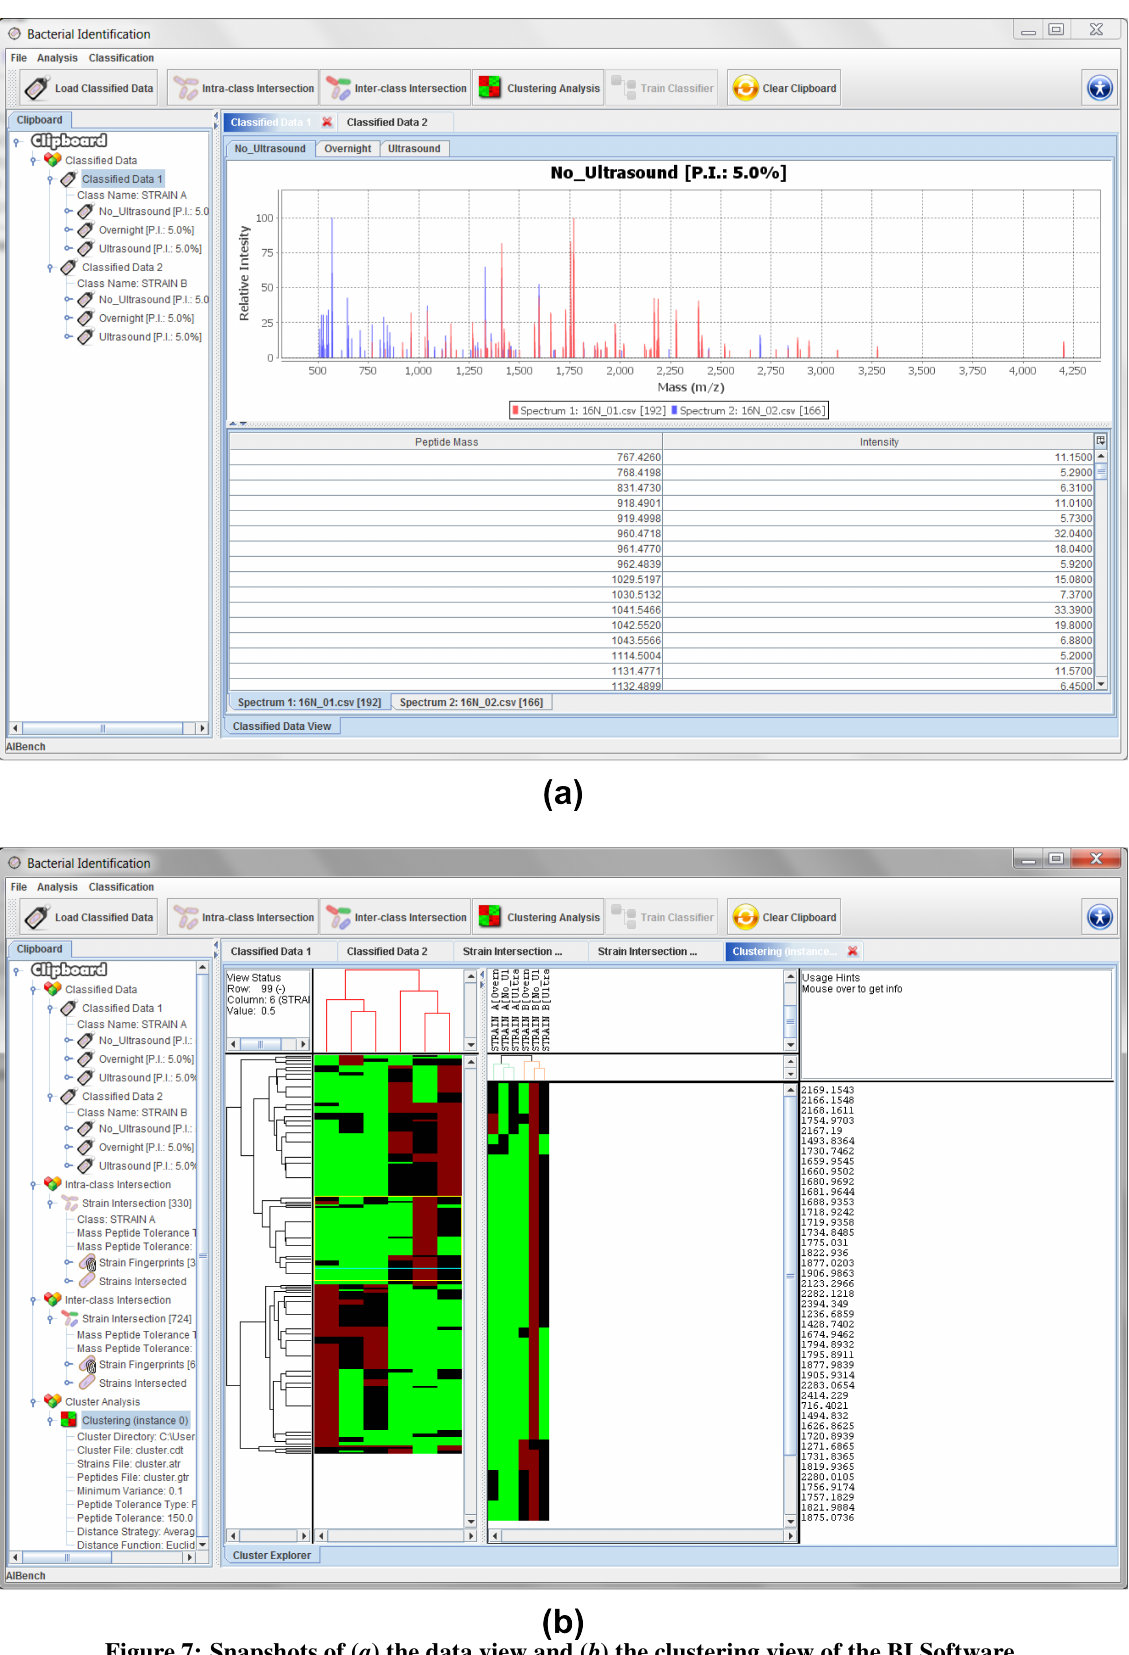
Figure 7: Snapshots of ( a ) the data view and ( b ) the clustering view of the BI